Question: Is the quantity shown trending increasing or decreasing?
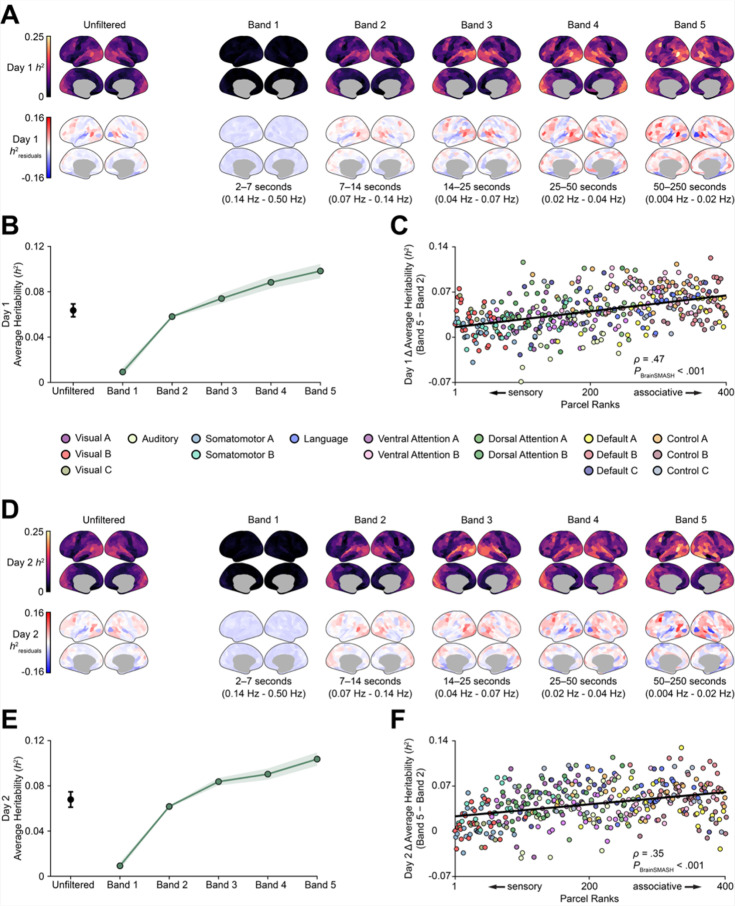
Answer: increasing